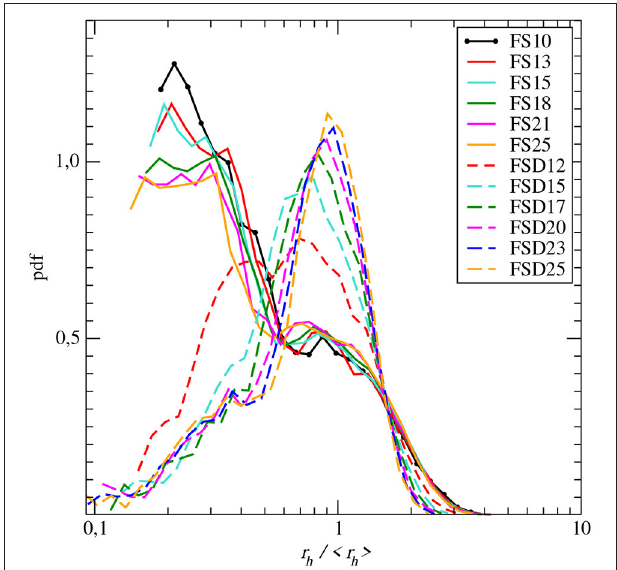
FIGURE 4 | Normalized distribution of r h for the FS and FSD samples.